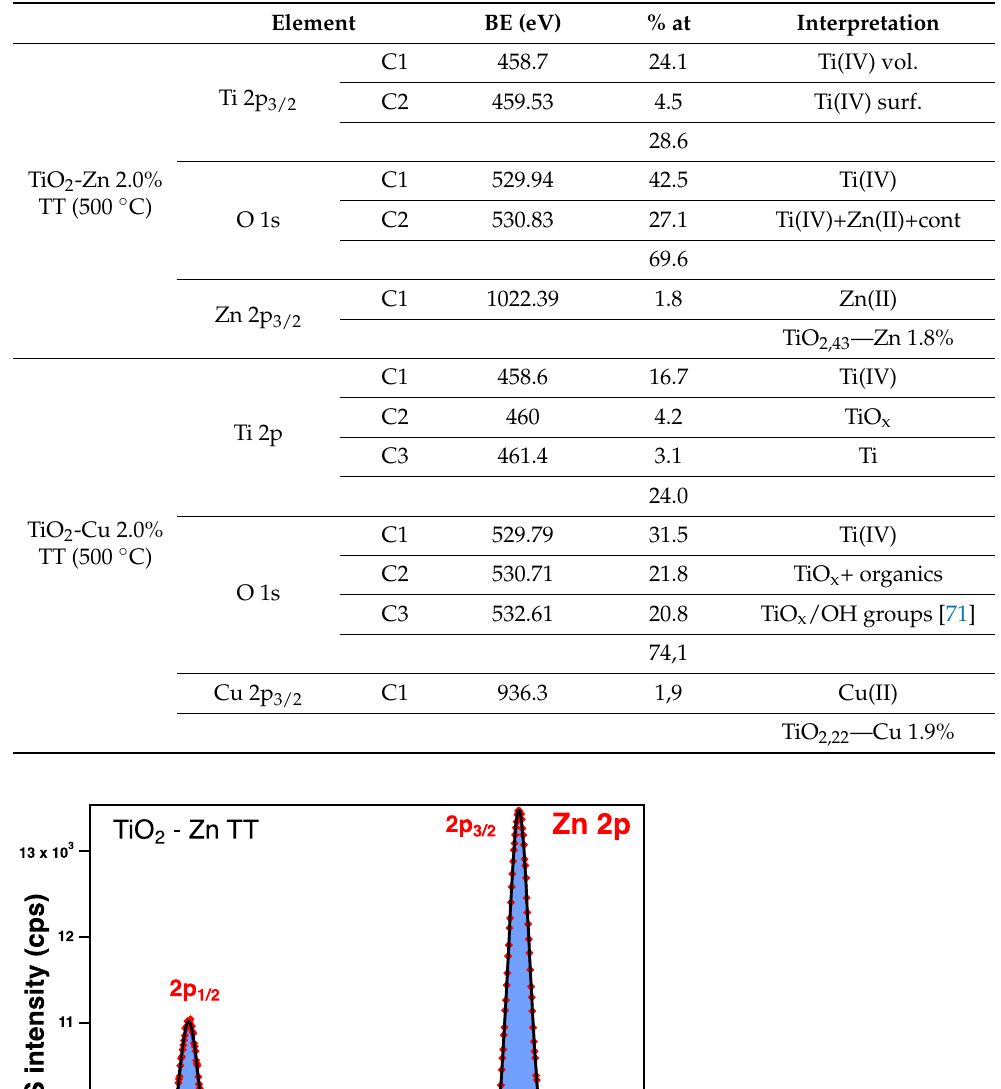
Table 5. Binding energies (BE), atomic %, and a tt ributions of the deconvolutions for the core levels for the treated samples.